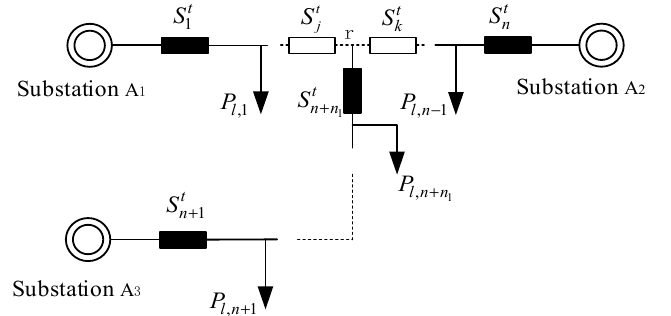
Figure 3. T-type series supply wiring mode.